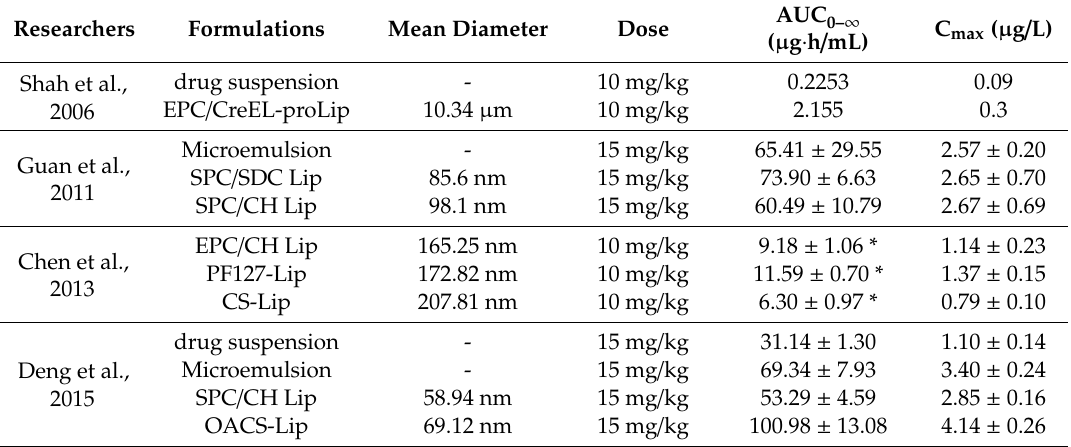
Table 5. Pharmacokinetic parameters of cyclosporine A in rats from di ff erent studies.